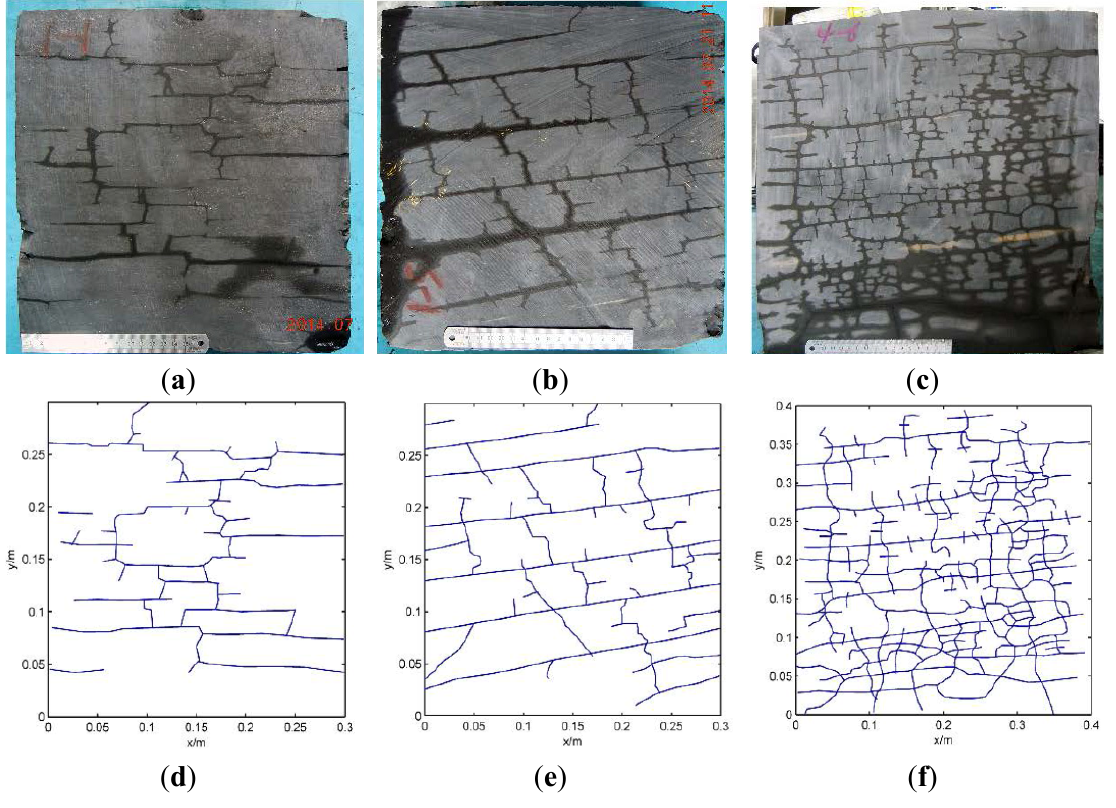
Figure 1. The natural fracture networks created from the rock sample: ( a – c ) are the surfaces of the rock sample that wetted by water; ( d – f ) are the main fractures obtained from the rock sample. Two characteristics are important to our